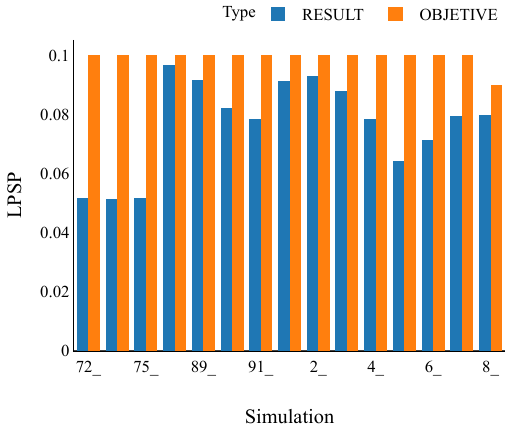
Figure 11. LPSP objetive vs LPSP result for some